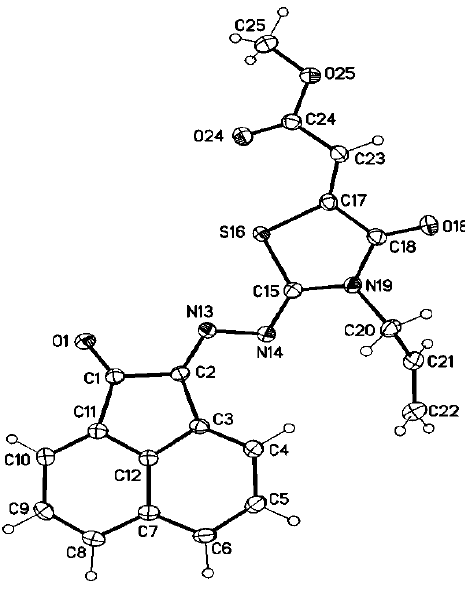
Figure 3. Molecular structure of 7d (displacement parameters are drawn at 50% probability level).